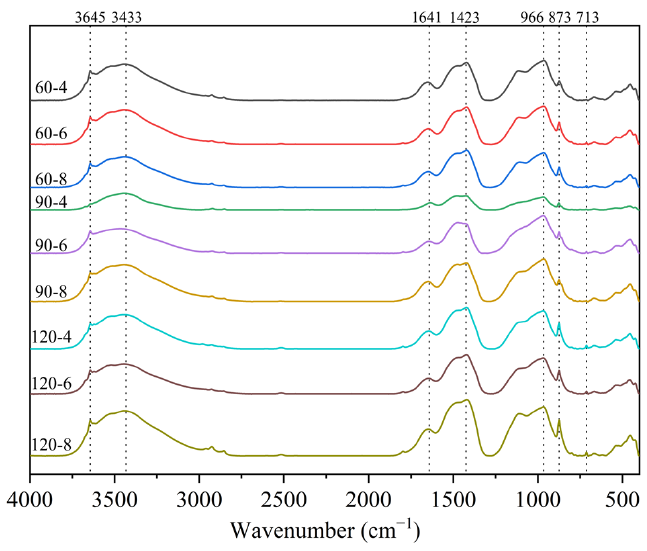
Figure 3. FTIR spectra of PC-CFC.